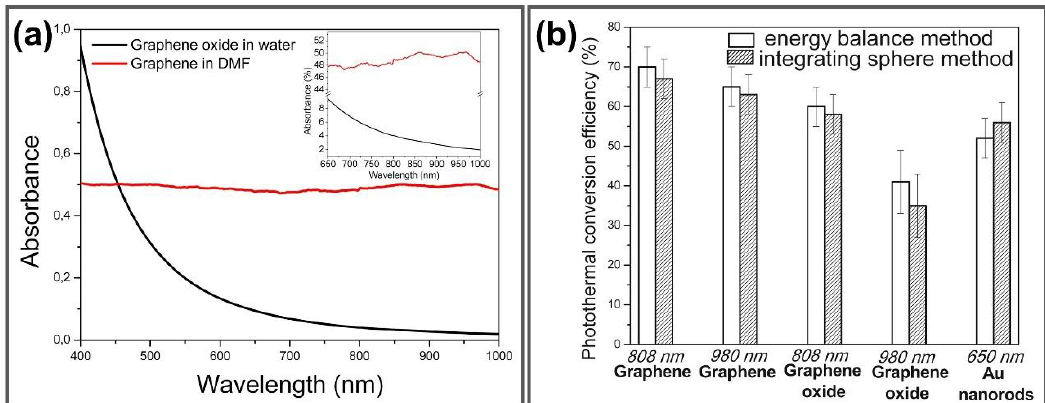
Figure 3. ( a ) Absorption spectra of graphene in dimethylformamide and GO in water in both visible and NIR range, inset is magnification of spectra from 650–1000 nm. ( b ) Photothermal conversion efficiencies of graphene, GO and Au nanorods determined by time constant and integrating sphere methods. Adapted with permission from [80] .